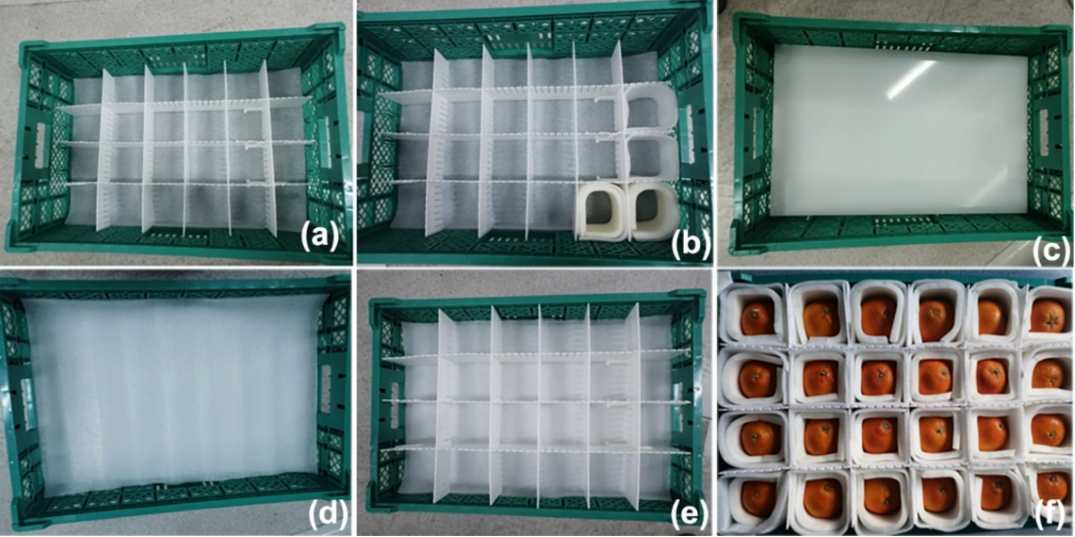
Figure 2. Structure of Packaging C: ( a ) The bottom of the lower layer was covered by an EPE foam board covering the whole layer area, and the lower layer was separated into 24 units by hard plastic partition boards. ( b ) An EPE foam layer was placed along the inside of the wall of each unit, and a polyurethane (PU) foam layer was placed along the inside of the EPE foam layer. ( c ) A hard polypropylene (PP) board was used to divide the folding plastic basket into upper and lower layers. ( d ) The bottom of the upper layer, which was the hard PP board, was covered by another EPE foam board. ( e ) The upper layer was separated into 24 units by hard plastic partition boards. ( f ) One unit had one citrus fruit, tightly wrapped by the PU foam layer, resulting in 24 fruits in one